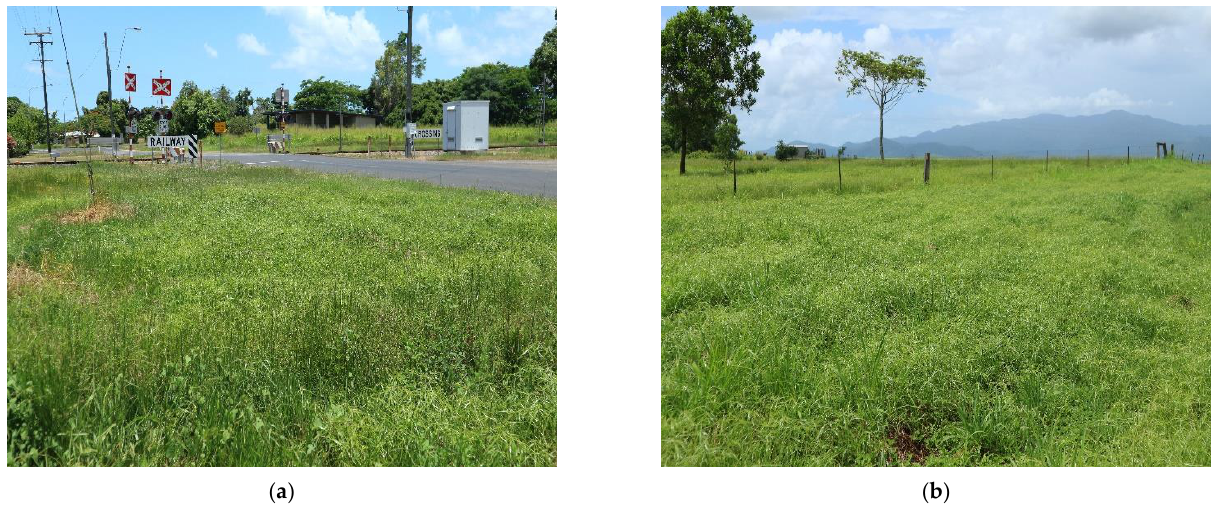
Figure 2. The invasion of Navua sedge ( Cyperus aromaticus ) in Australia; ( a ) near railway, ( b ) pasture land; ( c , d ) sugarcane farms, ( e ) along the creek, ( f ) along the